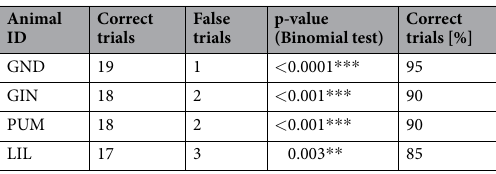
GND ( M. l .) GIN ( M. l .) PUM ( M. m .) LIL ( M. m .)